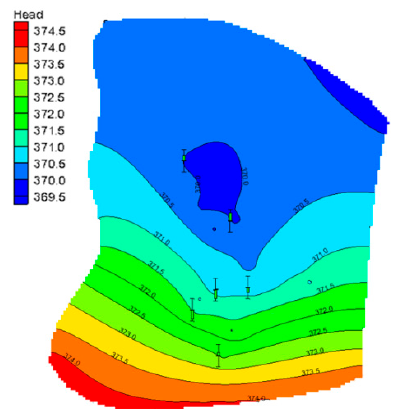
Figure 9. Distribution of water level and flow field at different simulation times.( a ) Simulates the water level after 3 years under nomal pumping conditions ( b ) Simulates the water level after 5 years under nomal pumping conditions ( c ) Simu- lates the water level after 10 years under nomal pumping conditions ( d ) Simulates the water level after 13 years under nomal pumping conditions ( e ) Simulates the water level after 15 years under nomal pumping conditions ( f ) Simulates the water level after 20 years under nomal pumping conditions.